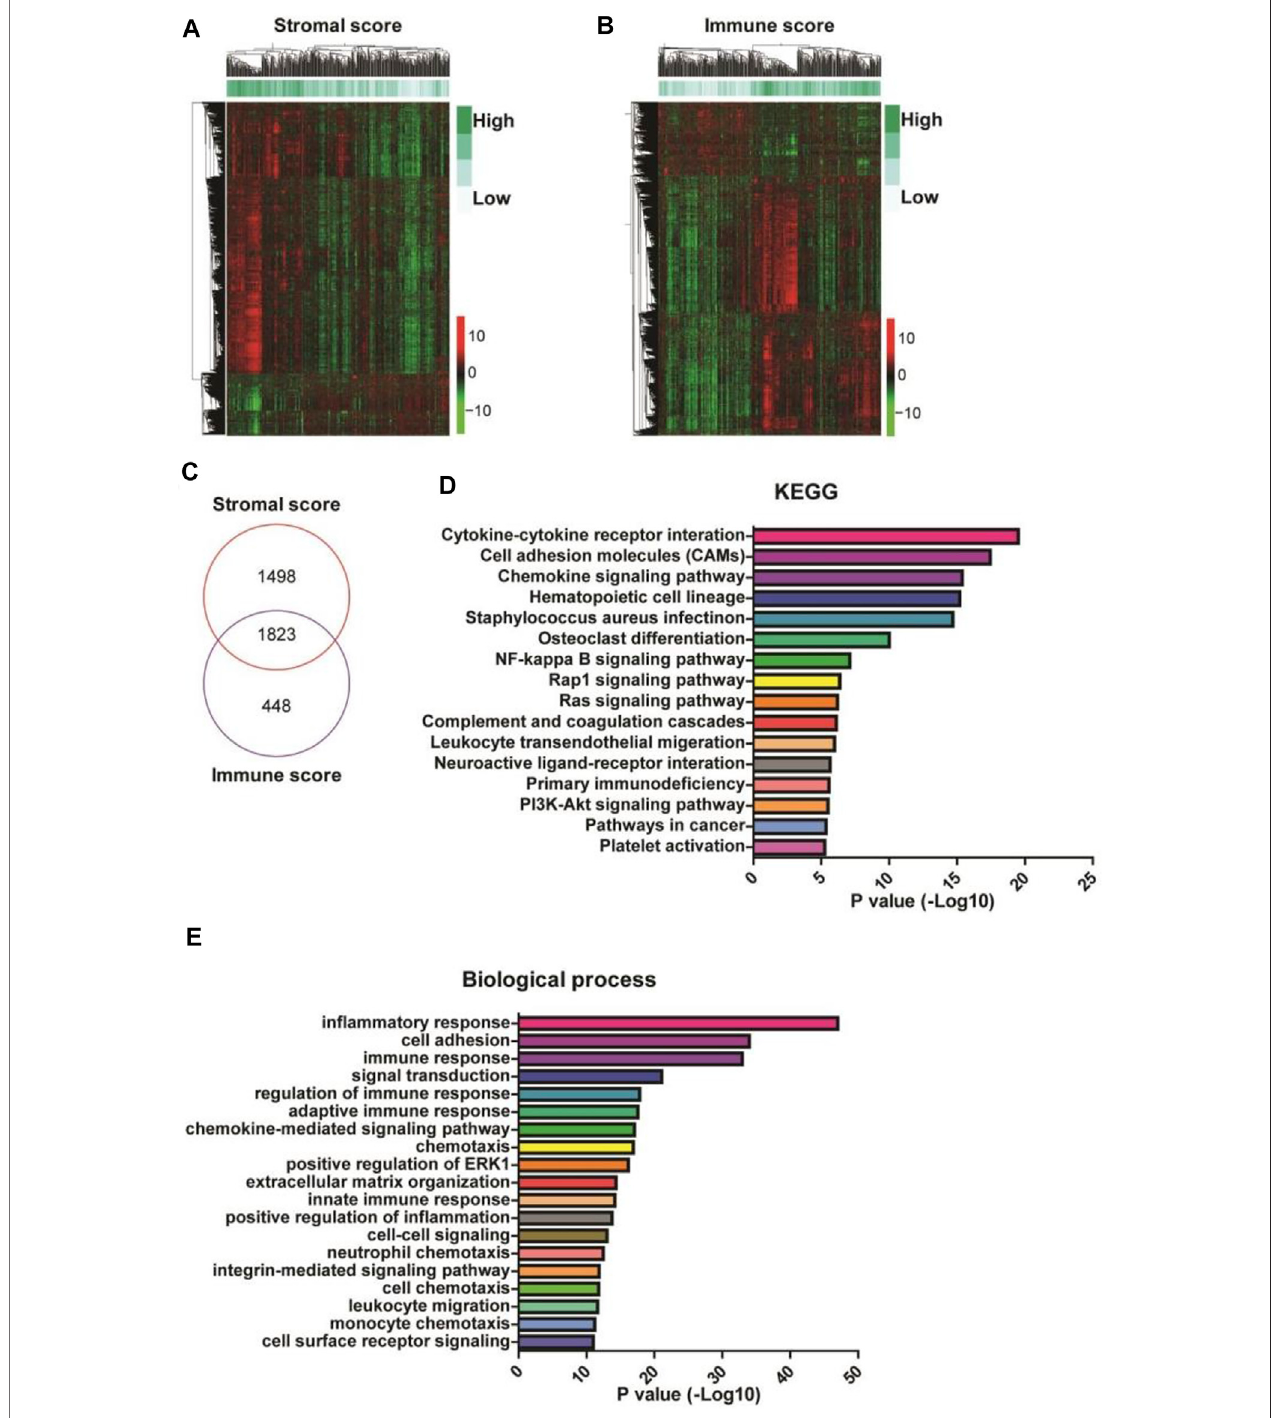
FIGURE 2 | Identi fi cation and enrichment analysis of differentially expressed genes (DEGs) in gastric cancer patients with high stromal and immune scores. (A,B) The heatmaps of the DEGs (|Log2 fold-change| > 1.5 and adjusted p -value < 0.001) in gastric cancer patients with high stromal (left) and immune (right) scores. (C) A Venn diagram depicts 1823upregulated DEGs in the intersection between high stromal and high immune scores-related DEGs. (D,E) Functional enrichment analysis of the DEGs was performed using Gene Ontology (GO) terms and Kyoto Encyclopedia of Genes and Genomes (KEGG) pathways.